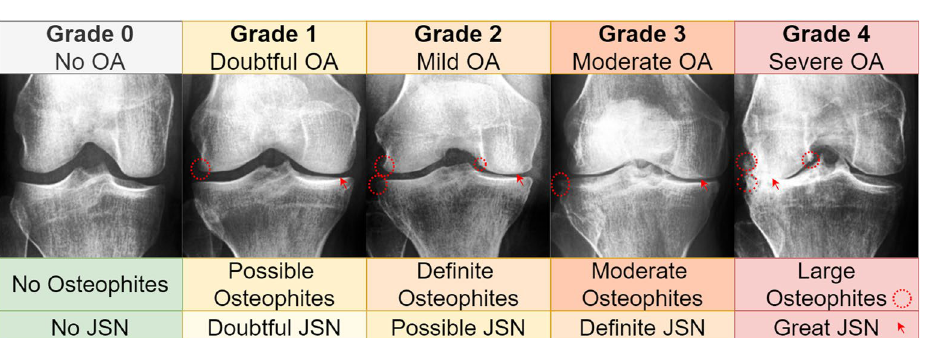
Figure 6. Random examples for each KL grade with main KL criteria. From left to right , we increase KL grade from 0 (no radiological signs of OA) to 4 (severe OA), JSN refers to joint space narrowing. Examples contain two red markers; the circular marker indicates regions with osteophytes. The arrow shows joint space